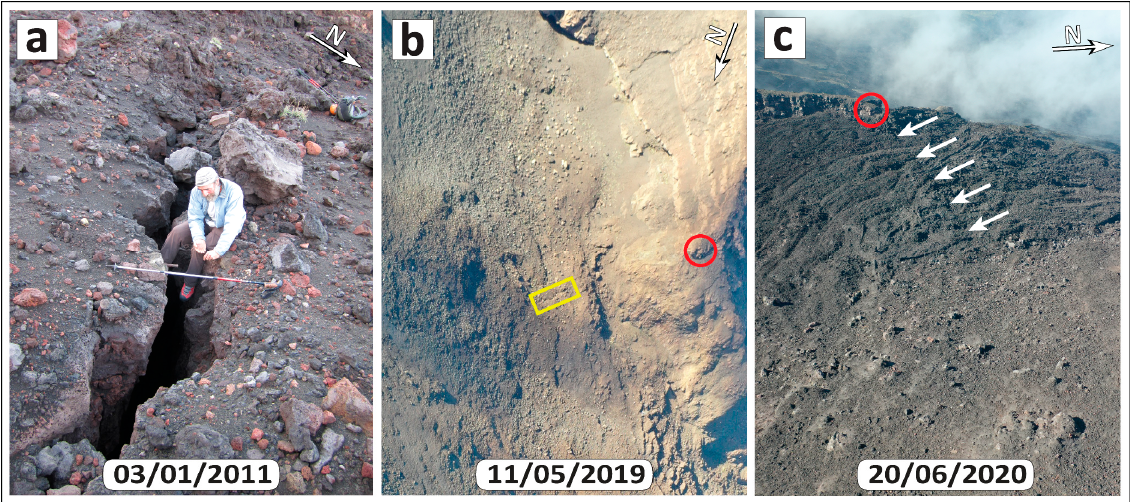
Figure 8. Recent evolution of the main N30° fissure belonging to the “fratture Tibaldi” fissure swarm. ( a ) Close-up view of the fissure. ( b ) Pre-eruption aerial image of the SW sector of SdF and the fissure shown in 8a ( yellow rectangle ). ( c ) Post-eruption aerial image of the SW sector of SdF and the new surface expression of the N30° fissure ( white arrows ). Red circles identify common areas in 8b and c.